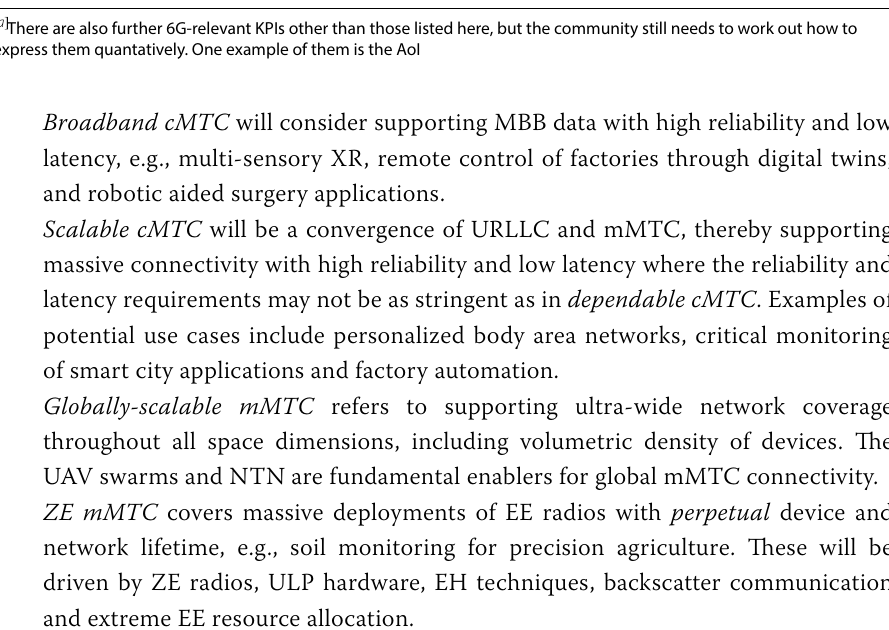
[ a ] There are also further 6G-relevant KPIs other than those listed here, but the community still needs to work out how to express them quantatively. One example of them is the AoI